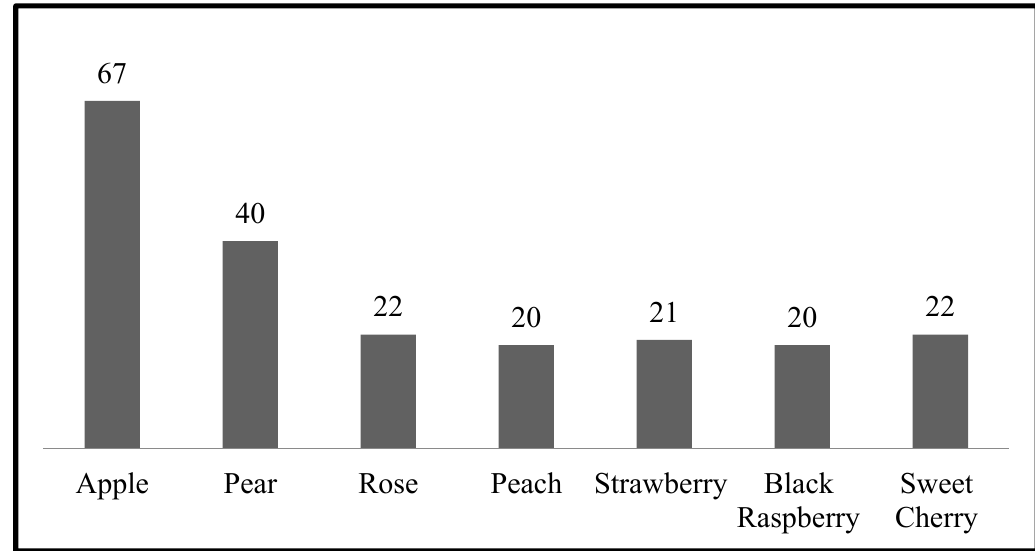
Figure 1. Graphical presentation of BBX gene members in seven Rosacea species genome.